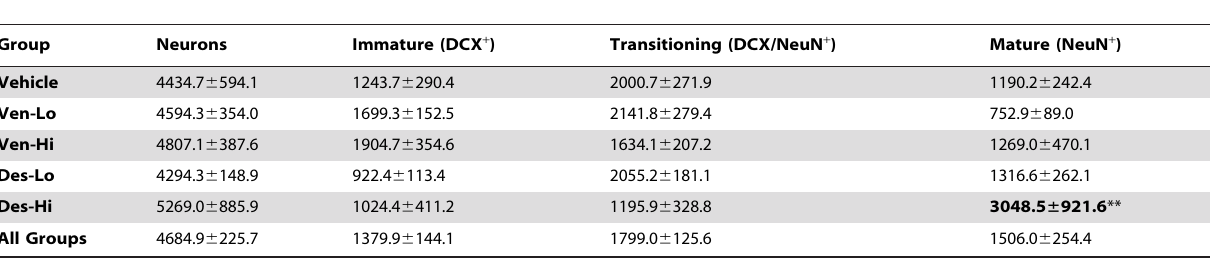
Table footnote. The total number of new BrdU + cells estimated stereologically was multiplied by the % of cells expressing a DCX + immature neuronal, DCX/NeuN + transitioning neuronal or NeuN + mature neuronal phenotype to obtain total new neuron number in the hippocampi of each rat. ** p , 0.01.